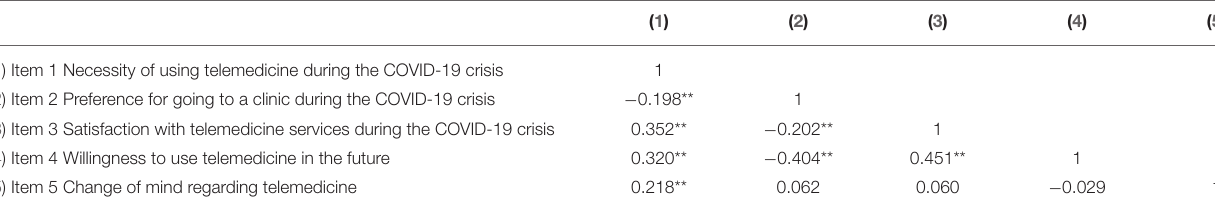
TABLE 3 | Spearman’s rank correlation between questionnaire items ( N =